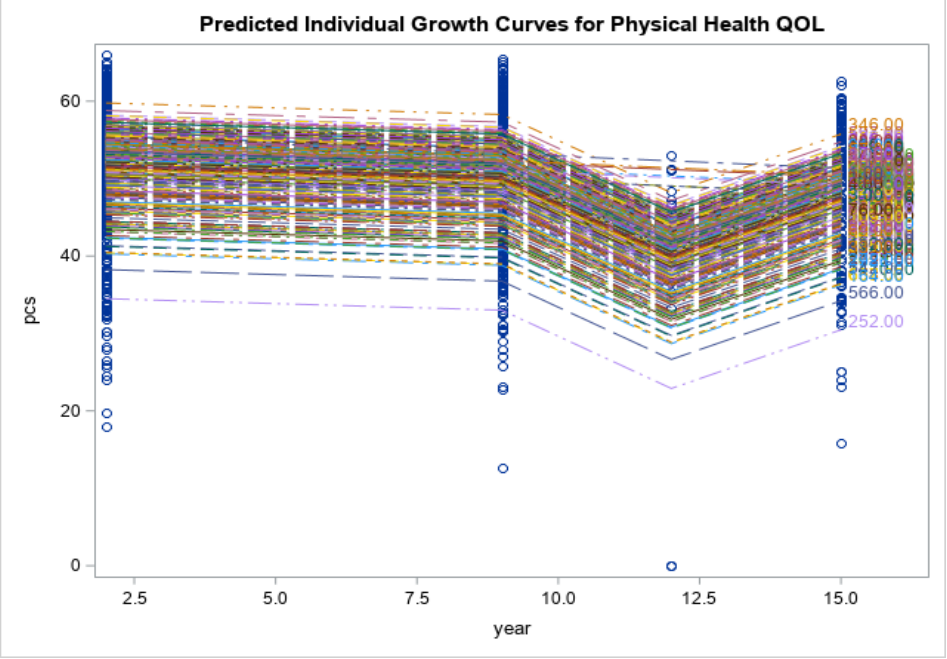
Figure 6. Predicted individual growth curves for physical health related. The blue lines indicate the measurement time points. measurement time